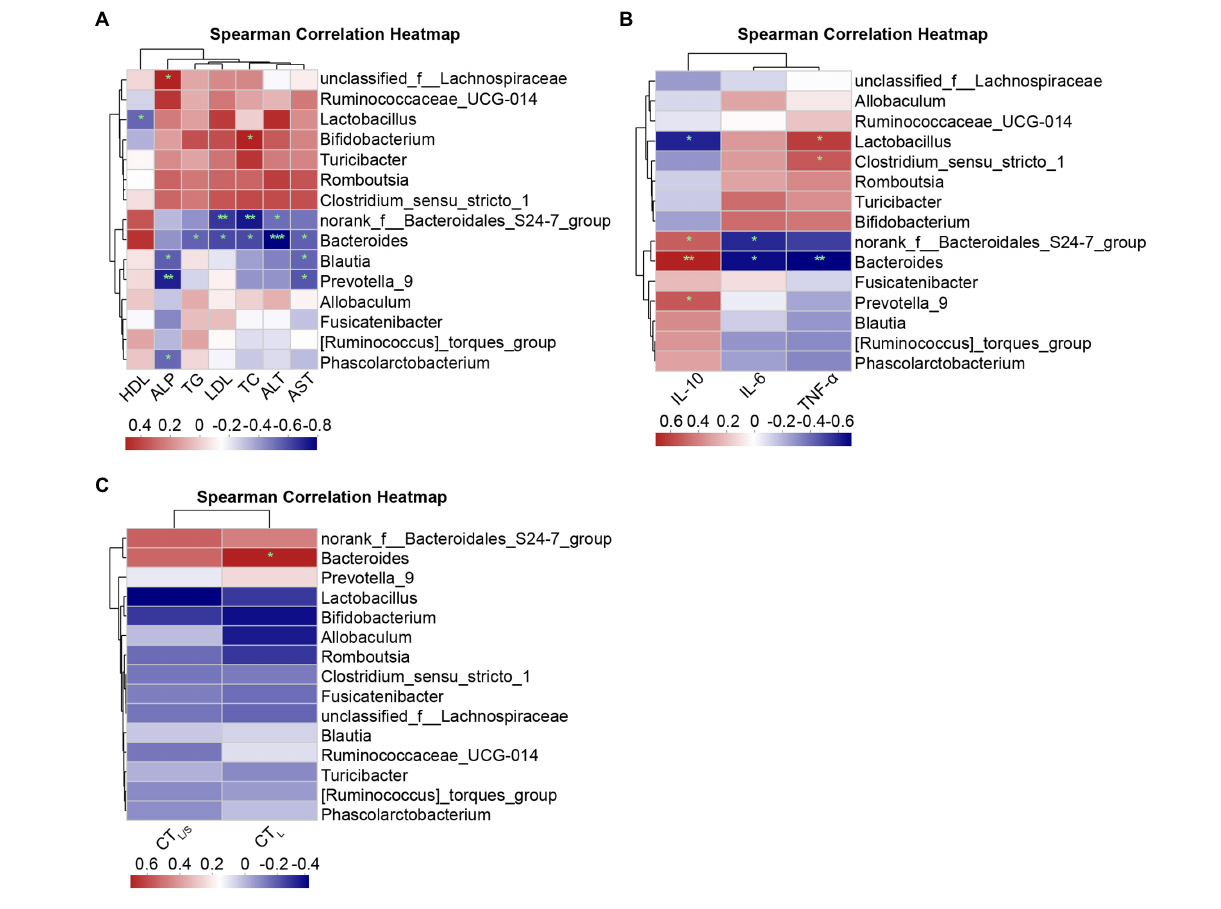
FIGURE 10 Spearman correlation heatmaps at the genus level. (A) Correlation heatmap of the serum lipid metabolism parameters ALT, AST, ALP, TC, TG, HDL, and LDL with the intestinal microbiota. (B) Correlation heatmap of the inflammatory factors IL-6, TNF- α , and IL-10 with the intestinal microbiota. (C) Correlation heatmap of the hepatic steatosis indicators CT L and CT L/S with the intestinal microbiota. Red indicates a positive correlation, and blue indicates a negative correlation; the darker the color, the higher the correlation. Significant threshold: * p < 0.05, ** p < 0.01, *** p <